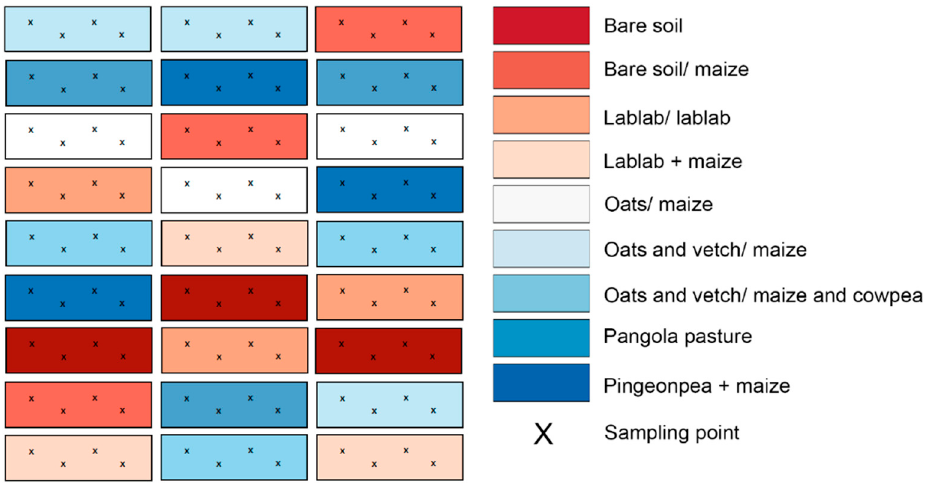
Figure 1. Experimental design and sampling points. Four core soil samples were taken from each one of the three replicates of the nine treatments (n = 108). Each plot has 10 m × 2 m.